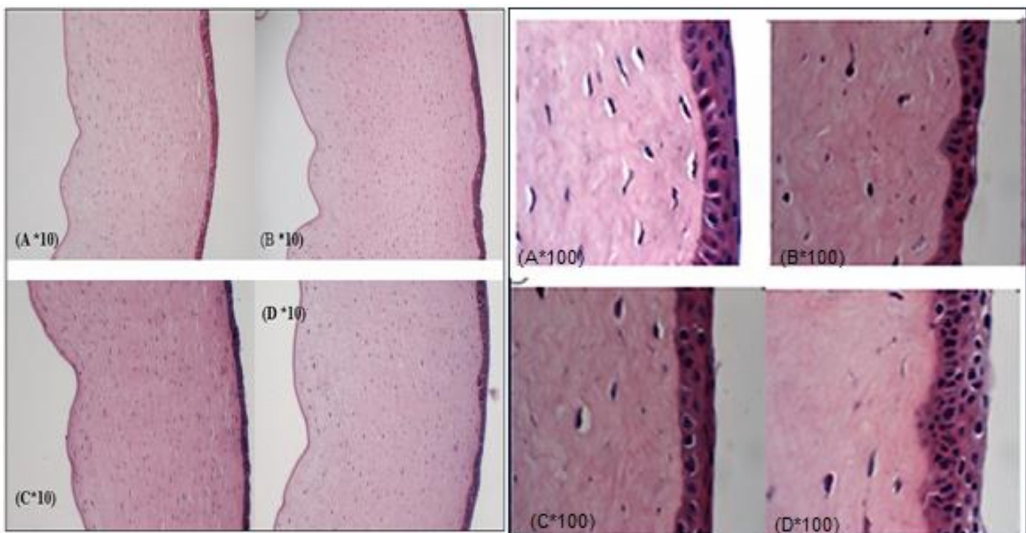
Figure 4. Corneal histology images of post trans-corneal permeation studies at 10 × and 100 × magnifications. Exposure of formulations: ( A ) TA-C, ( B ) TA-SLN, ( C ) TA-SLN-IG, and ( D )